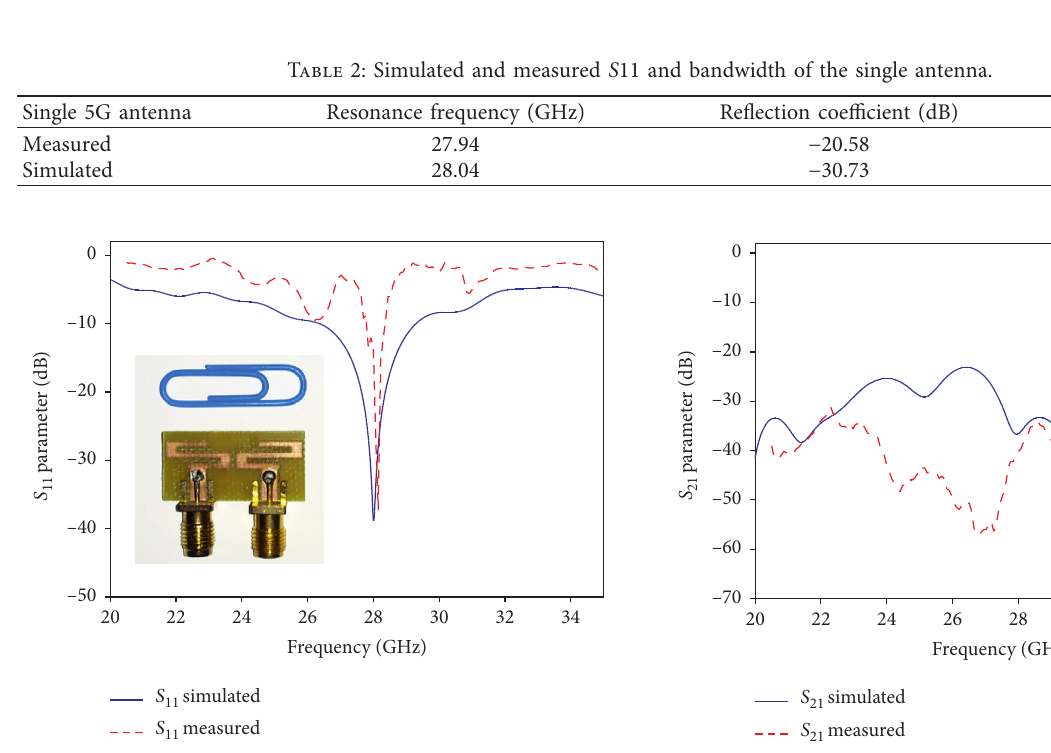
Figure 11: Simulated and measured reflection coefficients ( S 11) of the proposed MIMO antenna.